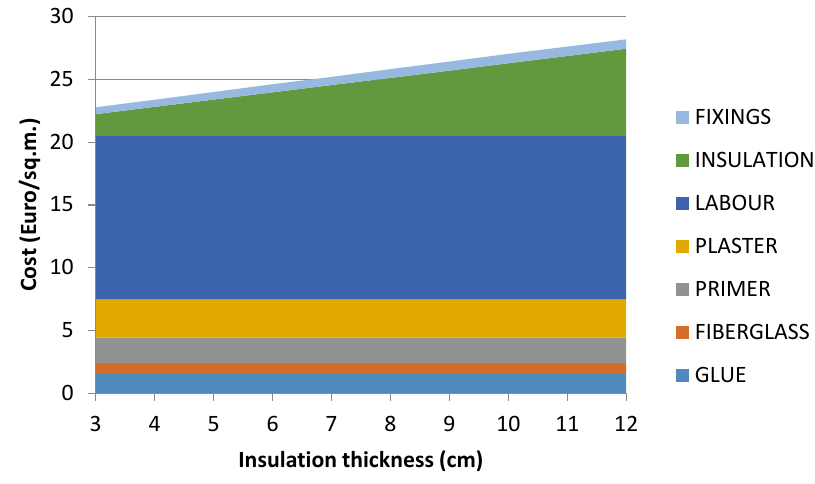
Figure 2. External insulation cost in retrofits, as a function of thickness.